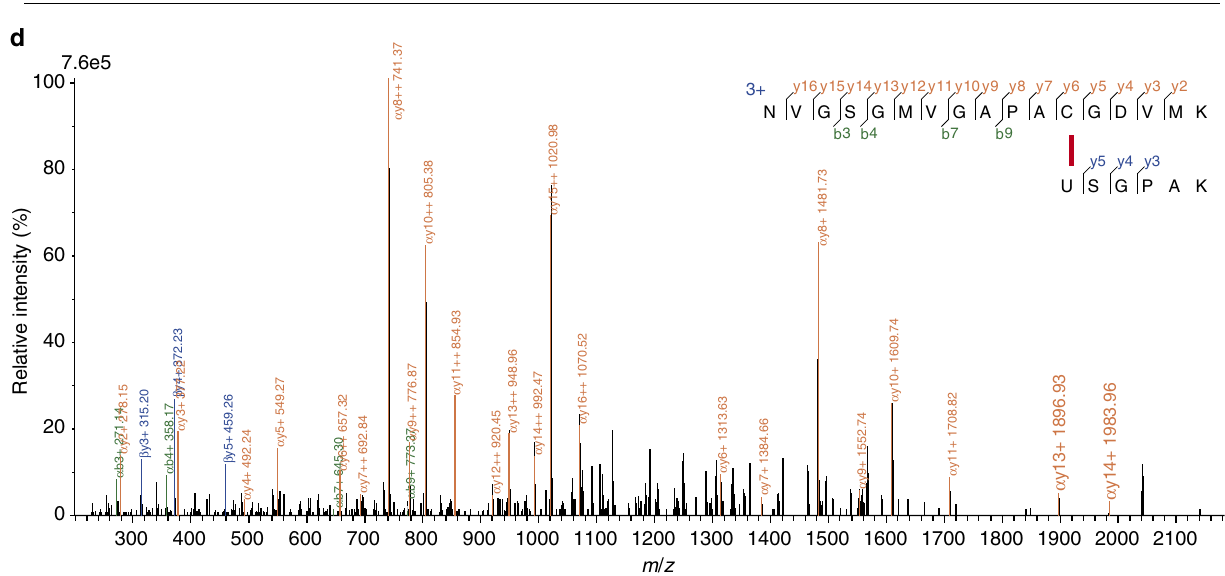
substrate – enzyme speci fi cities in these pathways and to identify potential drug targets in related pathophysiology. In addition,